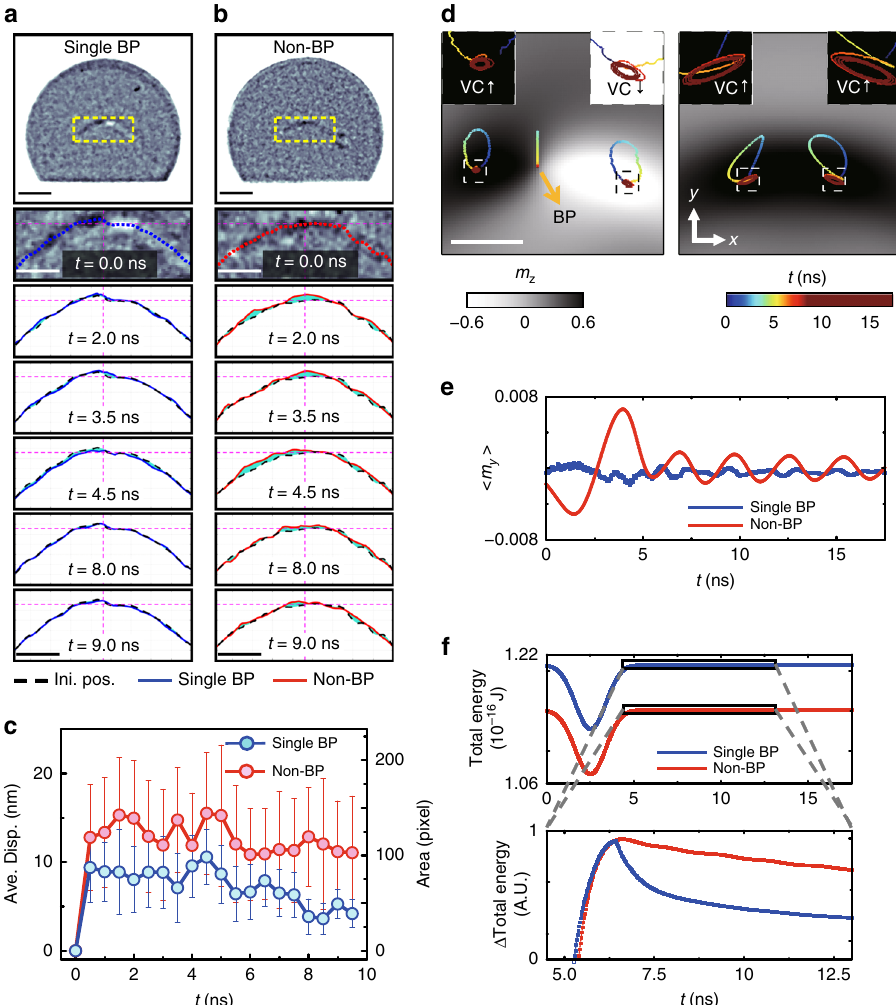
Fig. 4 Time-resolved measurements for the dynamics of a Bloch point (BP). a , b Representative images of the vortex core structures with ( a ) and without ( b ) a BP (the fi rst row) along with positions of core structures measured at t = 0, 2, 3.5, 4.5, 8, 9 ns during their dynamic processes triggered by the injection of a fi eld pulse with an amplitude of 50 Oe and the width of 3 ns in the + x -direction. The blue and red dotted lines in zoomed images correspond to the initial position of the core structures with and without BP. The red and blue lines indicate perturbed positions ( t > 0) of the single-BP core and non-BP core. Scale bars in ( a , b ) correspond to 500 nm (representative images) and 200 nm (zoomed images), respectively. c Quantitatively analysed differences between initial ( t = 0, black line) and perturbed positions ( t > 0) of the single-BP core (blue line) and non-BP core structure (red line). The experimental error bars are taken at one standard deviation. d Trajectory curves of the simulated dynamic motions of the BP and vortex cores with up (VC ↑ ) and down (VC ↓ ) polarizations in the single-BP and non-BP cores (scale bar: 50 nm). e , f The variations of normalized y -components of magnetizations, < m y > = < M y / M s > ( e ) and total energy ( f ) during the dynamic relaxation processes of the single-BP and non-BP cores. Raw data of Fig. 4c are provided as the